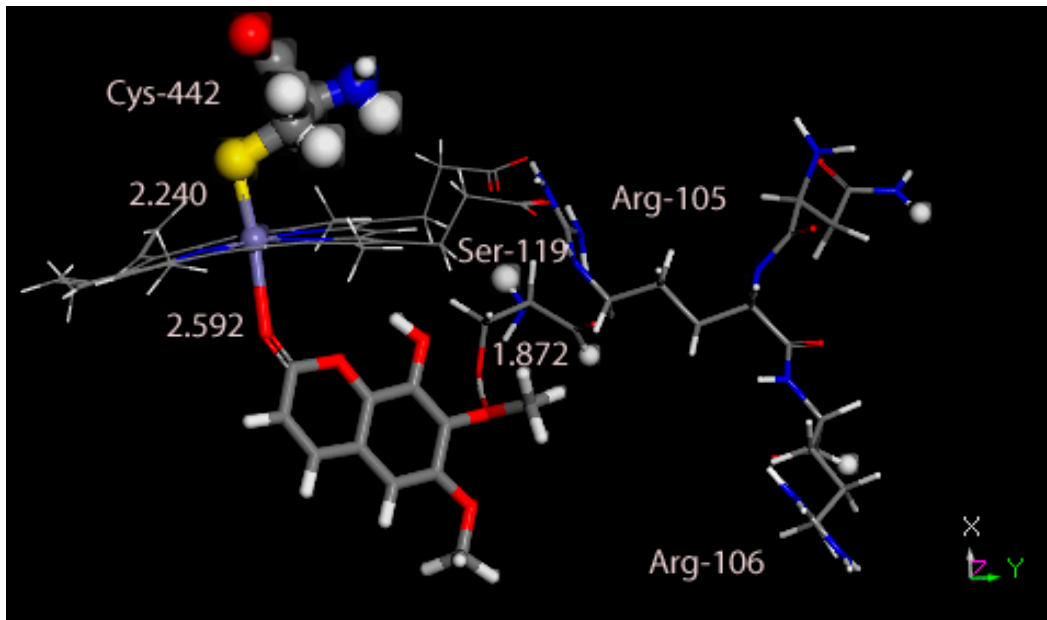
Figure 13. DFT optimized fraxidin pose 8 confirms Ser − 119 H-bond to the fraxidin O(methoxy) group in position 7, 1.872 Å (for clarity, this bond interaction is not dashed) and octahedral iron coordination, O(carbonyl)-Fe = 2.592 Å and S(Cys-442)-Fe = 2.240 Å. Arg-105 keeps its H-bonds with both heme carboxylates, 1.807 Å (NH 2 ) and 1.754 Å (NH) and Ser − 119, 2.018 Å (NH 2 ), with numbers omitted for clarity.